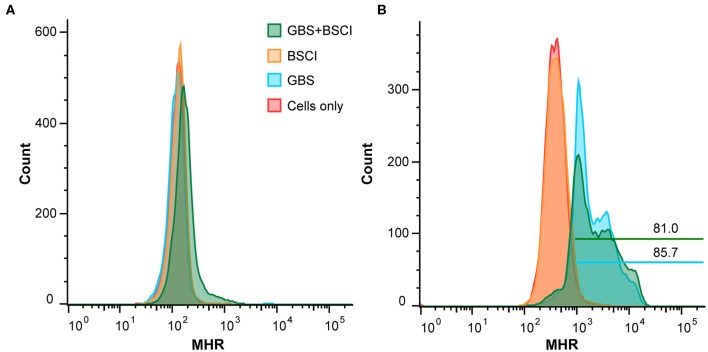
BSCI does not impact neutrophil production of ROS or survival. Adult human neutrophils were pretreated with 84 μM di-hydro-rhodamine 123. Subsequently, the neutrophils were treated with GBS in the presence or absence of BSCI and oxidation to fluorescent mono-hydrorhodamine 123 was monitored at baseline (A) or 60 min after GBS and/or BSCI treatment (B). Gates shown reflect the percentage of all cells. Adult human neutrophils were incubated with GBS in the presence or absence of BSCI. The total surviving bacteria (intracellular and extracellular) were enumerated 1 h after incubation. The survival index was calculated as the ratio of colony forming units (CFU) recovered in the presence of neutrophils to CFU recovered in the absence of neutrophils. Data shown are the average of two independent experiments with neutrophils isolated from three different donors for each experiment, which was performed in duplicate, error bars ± SEM.